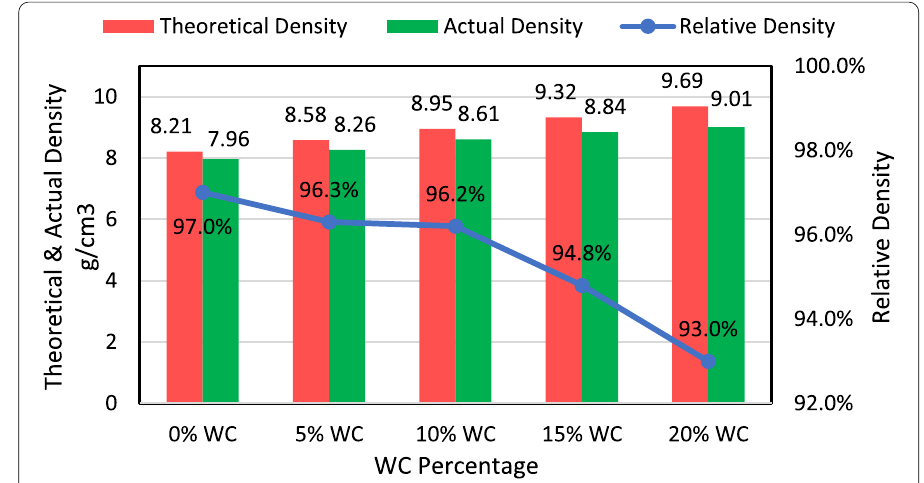
Fig. 3 Theoretical, actual, and relative densities of HEA vs. WC percentage